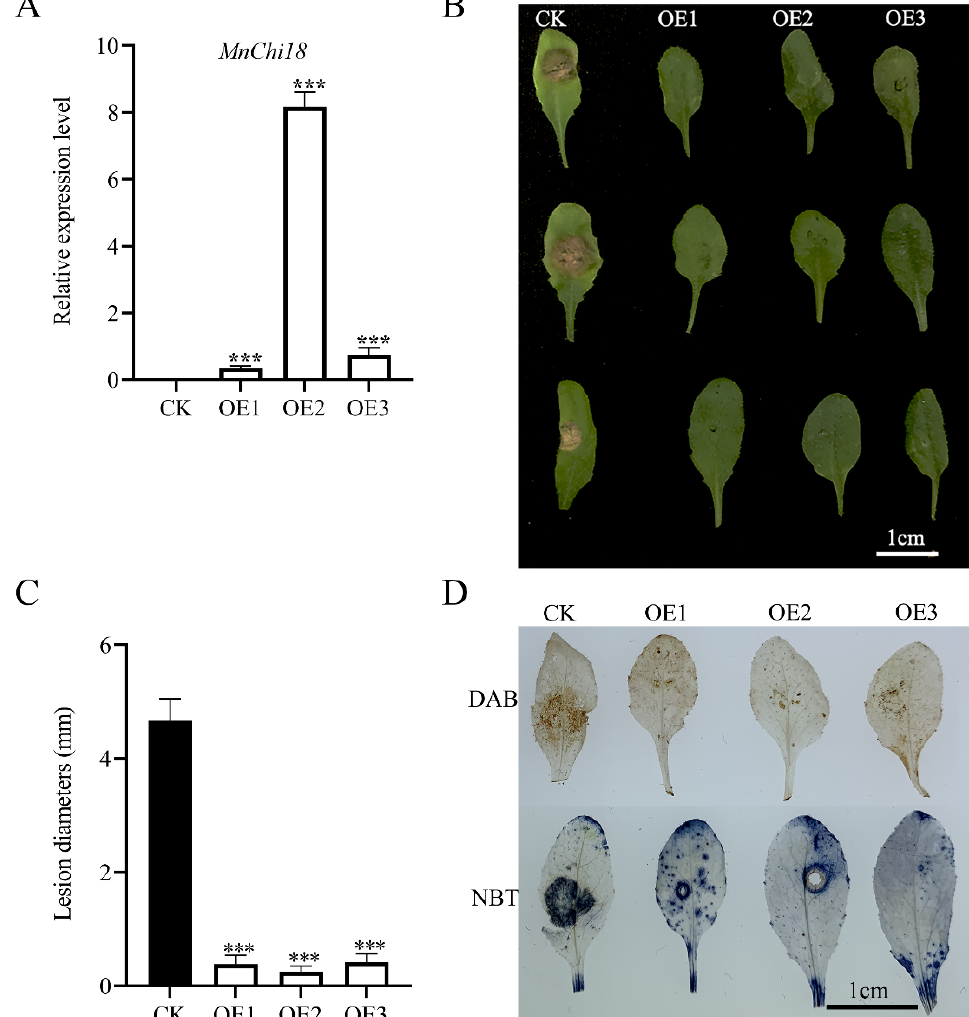
Figure 4. Resistance of transgenic Arabidopsis to B. cinerea . ( A ) Relative expression level of MnChi18 in transgenic Arabidopsis leaves. ( B ) The leaves of Arabidopsis were photographed for 36 hours after